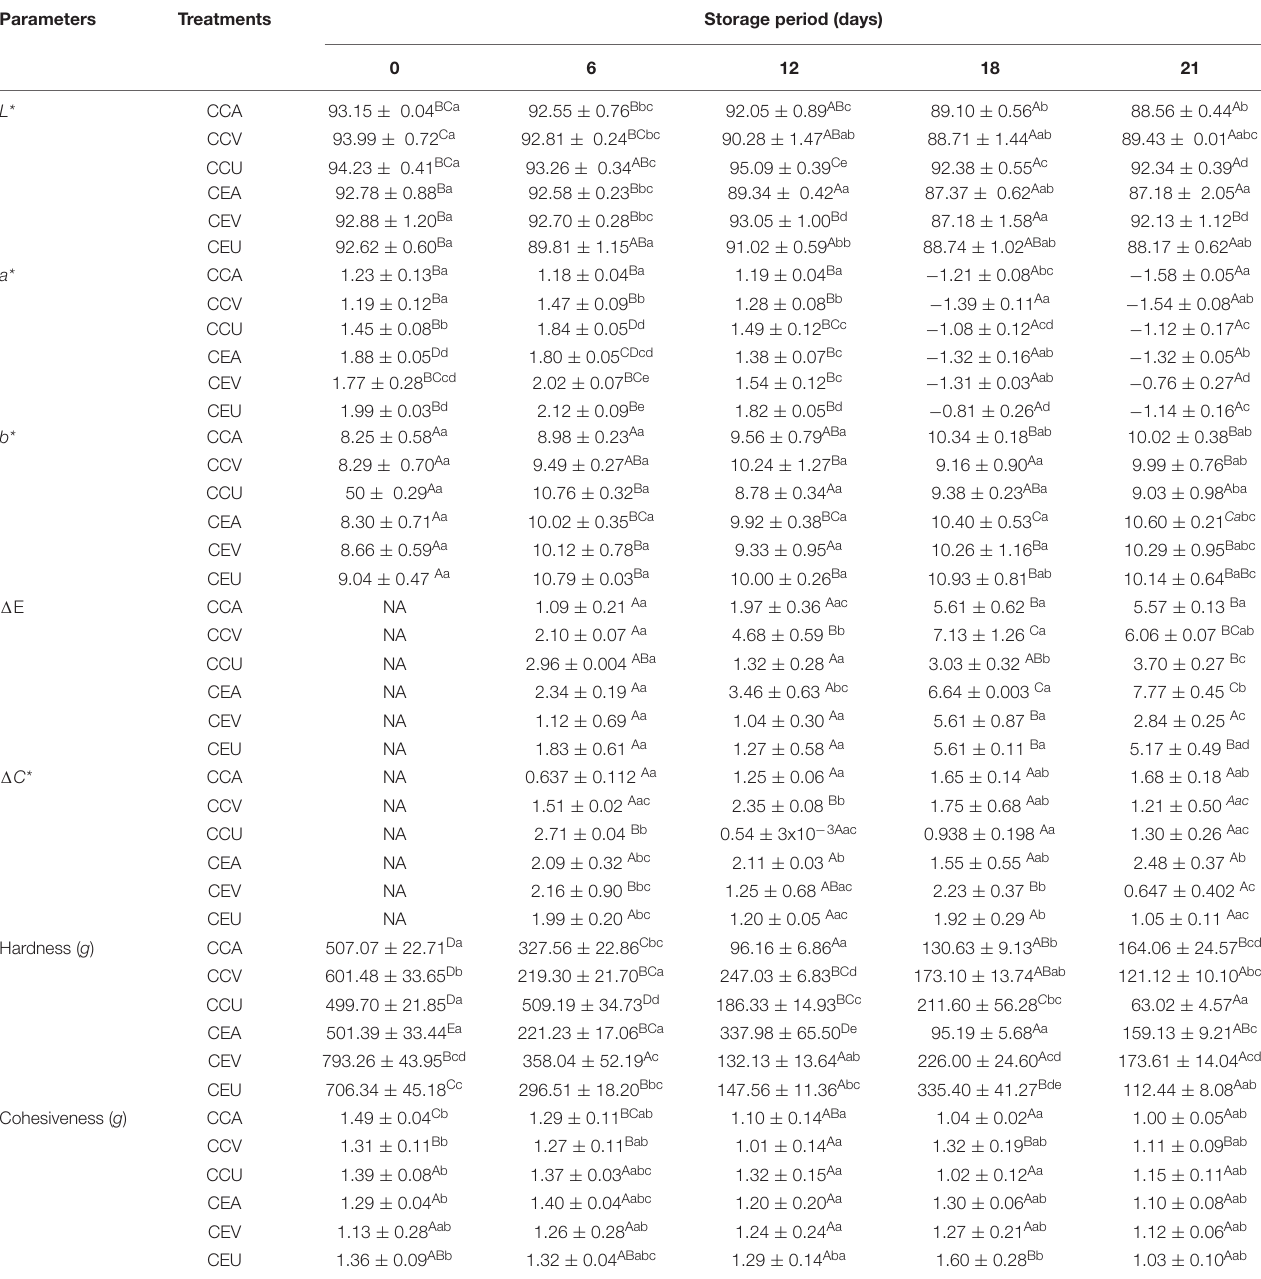
TABLE 3 | Instrumental color and texture characterization of raw goat milk cheeses during 21 days of storage at 4 ◦ C.